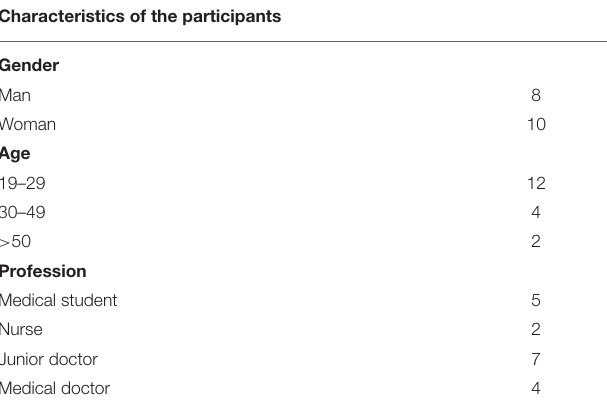
TABLE 1 | The experiences of health professionals while monitoring a hunger strike among undocumented migrant workers. Characteristics of the